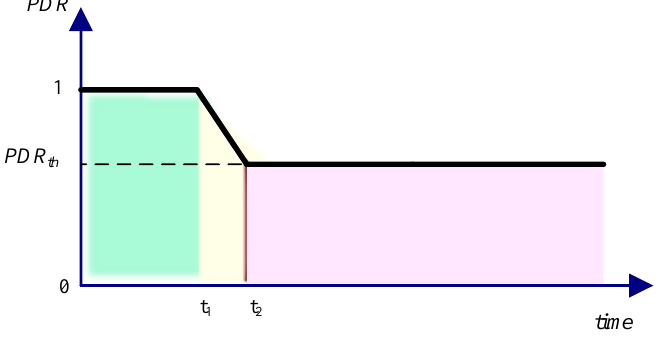
Figure 6. Resiliency curve of the SCN model for Case-II .